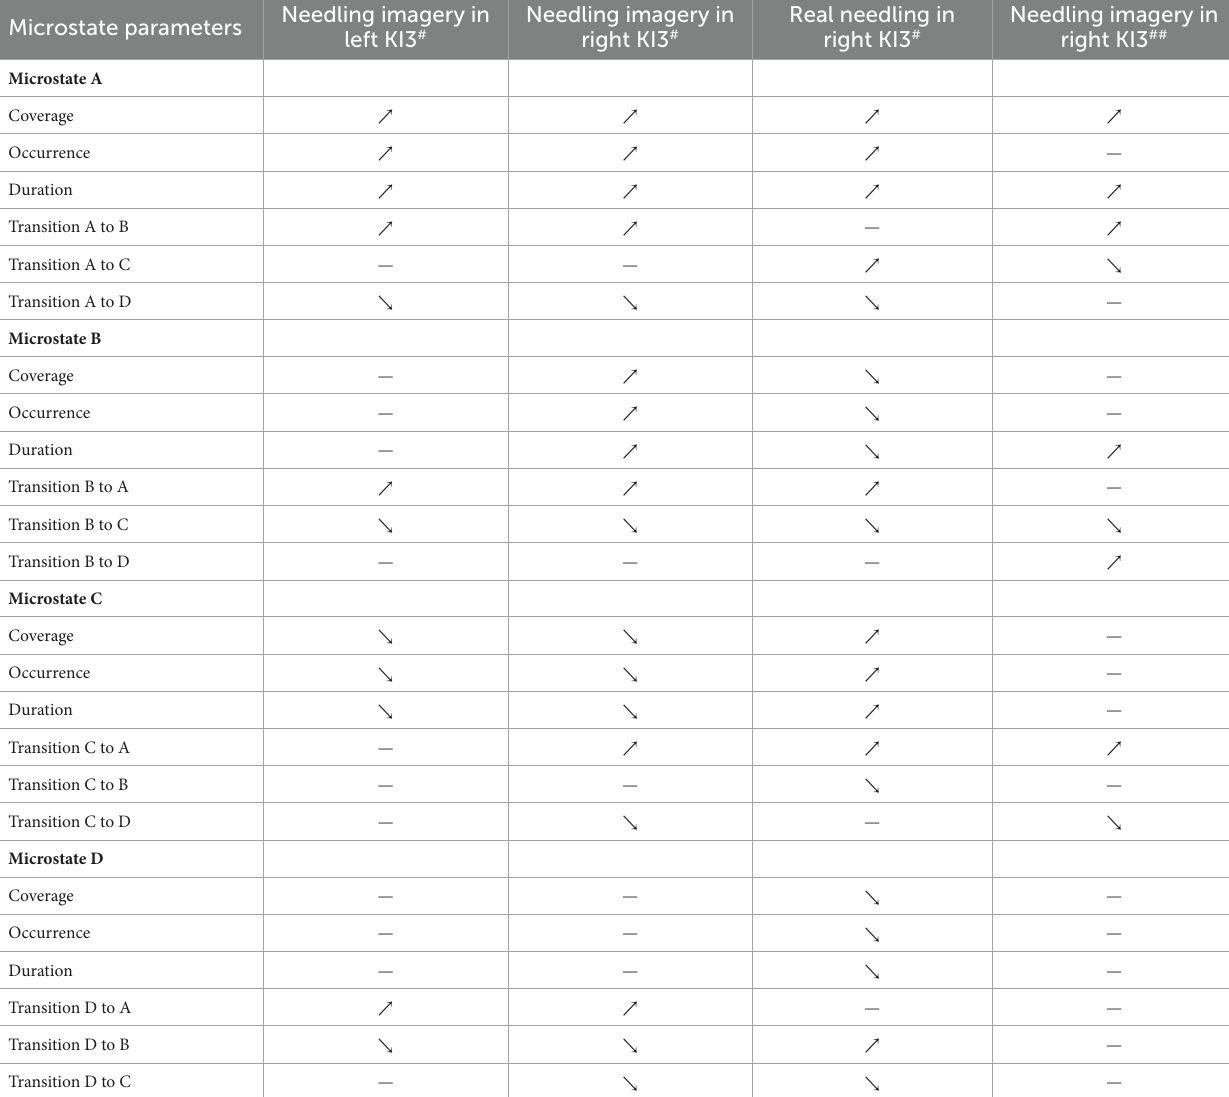
TABLE 2 Summary of changes of microstate parameters in acupuncture imagery and real needling in KI3.